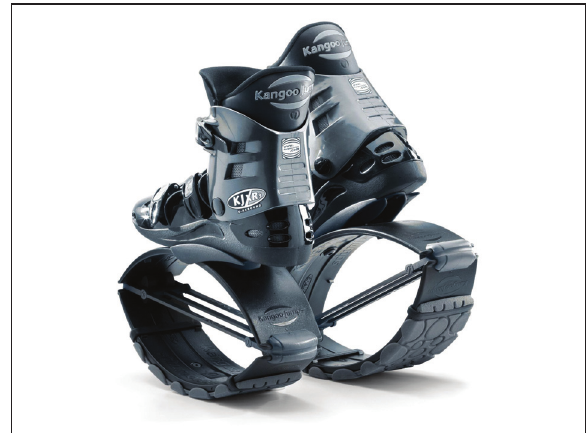
Figure 1 - Unstable footwear used in the study Source: Kangoo Jumps (24).